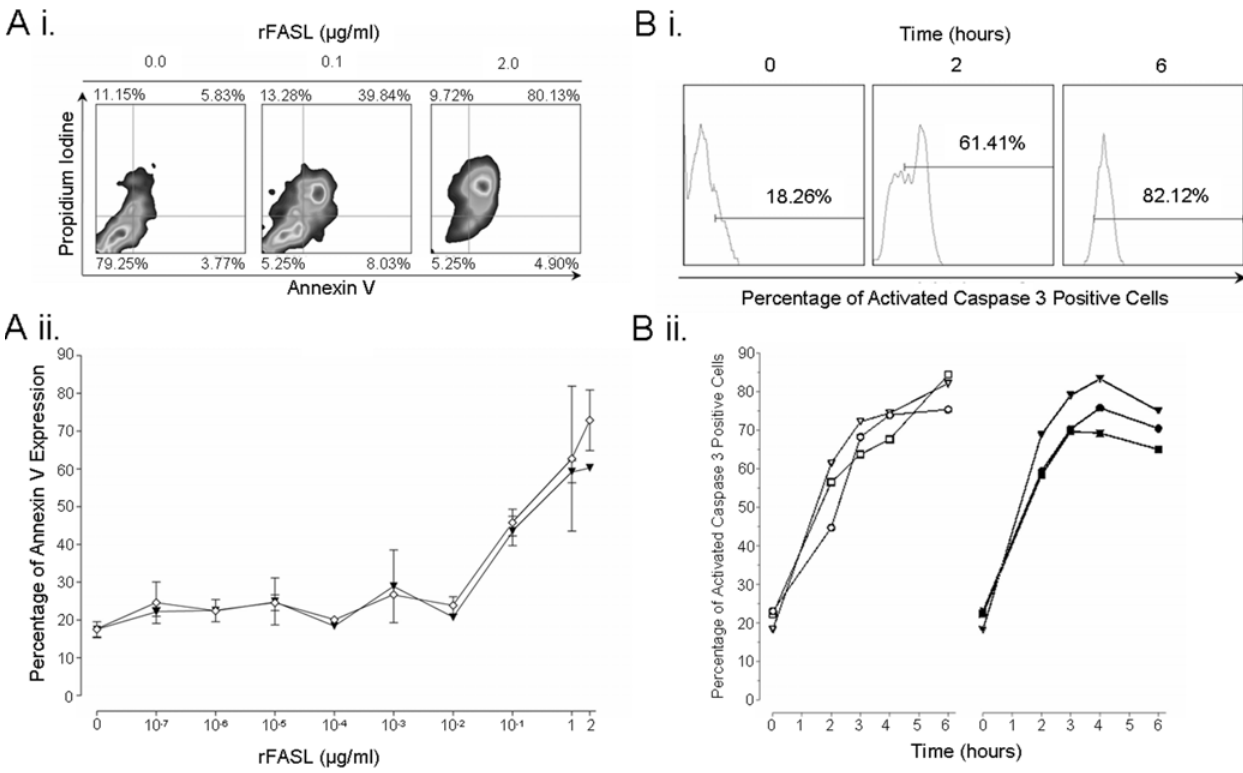
Figure 5. IFN- a treated hepatocytes remain susceptible to FASL-induced apoptosis. Aii ) Induction of apoptosis by FASL was assessed across a concentration range. HepG2 cells, either stimulated with IFN- a (1000 IU/ml) (closed inverted triangles) or left un-stimulated (open diamonds), were incubated with cross-linked rFASL at concentrations ranging from 0.1 pg/ml to 2 m g/ml. Apoptosis was assessed by Annexin V binding and propidium iodine (P.I) incorporation. Ai ) Raw FACS data is shown. Bii ) HepG2 cells, either un-stimulated (open and closed circles), stimulated with 100 IU/ml (open and closed squares) IFN- a or 1000 IU/ml (open and closed inverted triangles) IFN- a , were incubated with 1 m g/ml (left, open symbols) or 2 m g/ml (right, closed symbols) cross-linked rFASL over a time course of up to 6 hours. Apoptosis was assessed by the cytosolic presence of the activated form of caspase 3. Bi ) Raw FACS data.